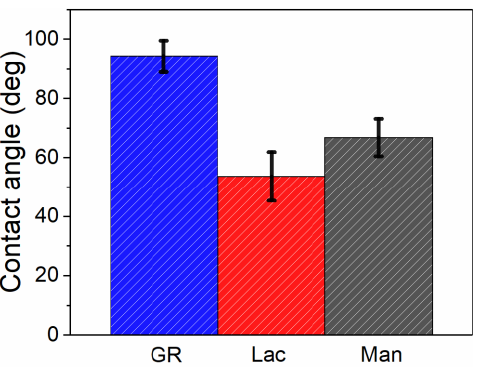
Figure 4. Water contact angle determinations of bare GR (blue), GR_Lac (red), and GR_Man (grey) electrodes used for MFC device testing.